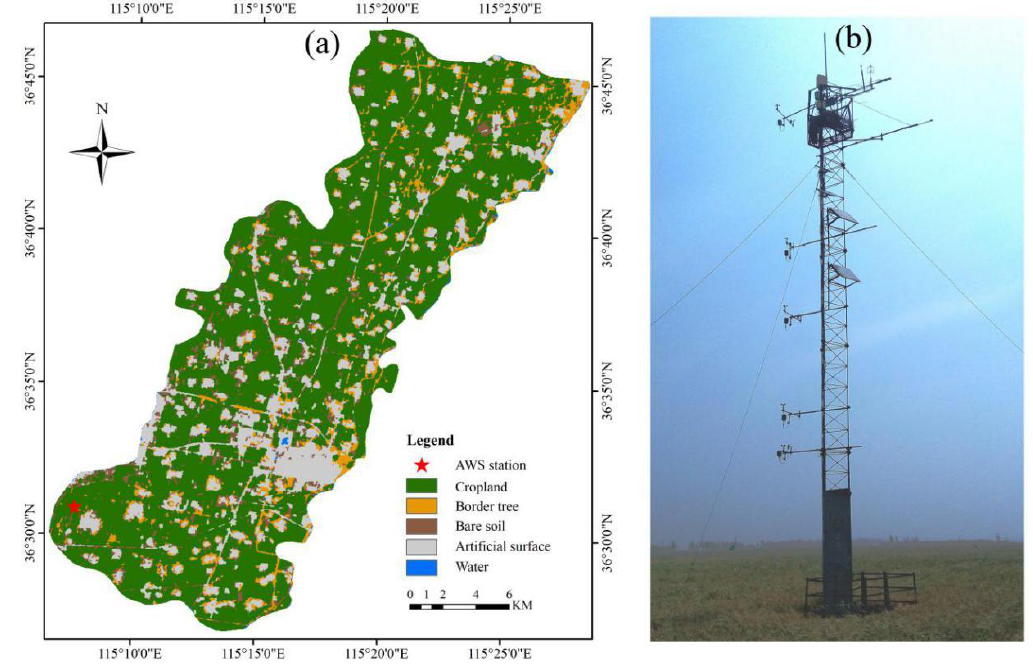
Figure 1. ( a ) Land cover map of Guantao County in 2014; ( b ) The photograph of the AWS and EC tower in Guantao during the winter wheat growing season.